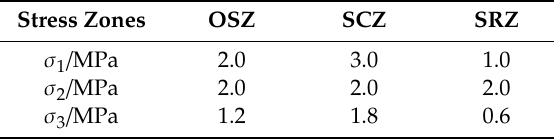
Table 1. Stress loading of the outburst at di ff erent zones.